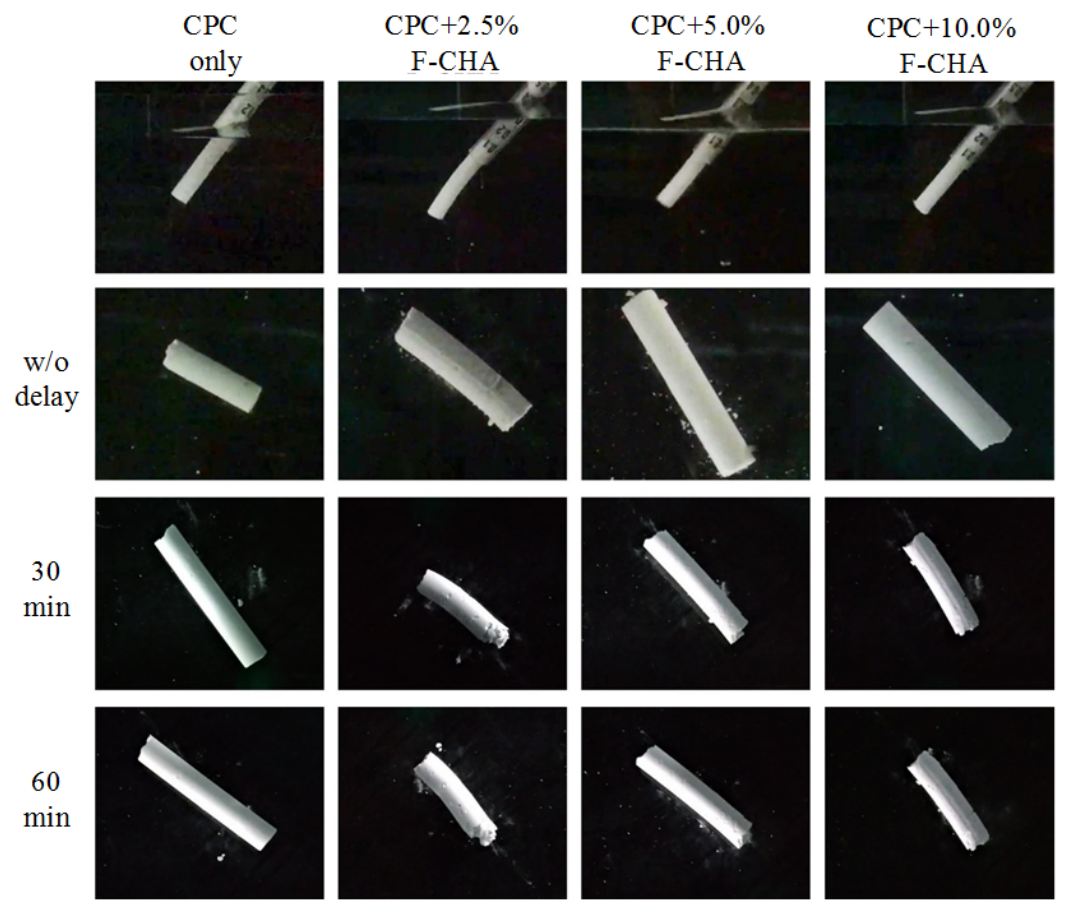
Figure 9. Injection and disintegration tests of CPC composites with different ratios of ferulic acid-carbonated apatite nanorods (CPC + F-CHA) after injection into ddH 2 O.